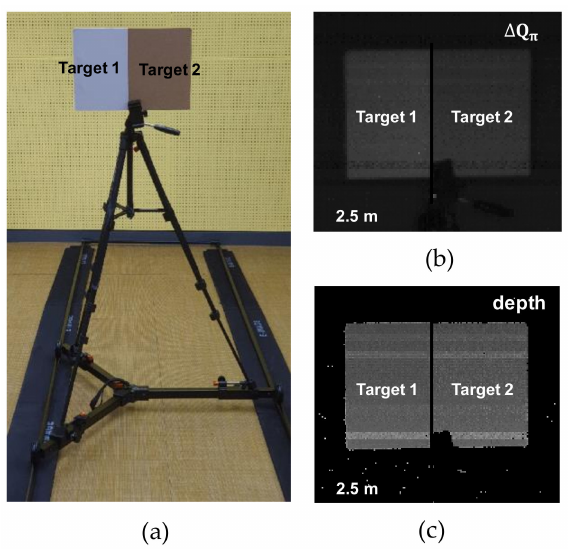
Figure 11. Testing environment and captured images from the fabricated sensor: ( a ) testing environment; ( b ) infrared (IR) image of ∆ Q π without application of a two-step comparison scheme; ( c ) depth image with application of a conventional four-phase modulation scheme.